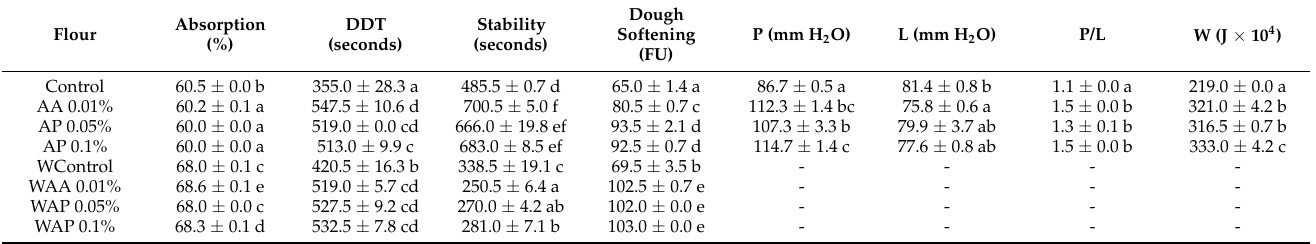
Table 1. Farinographic and alveographic properties of